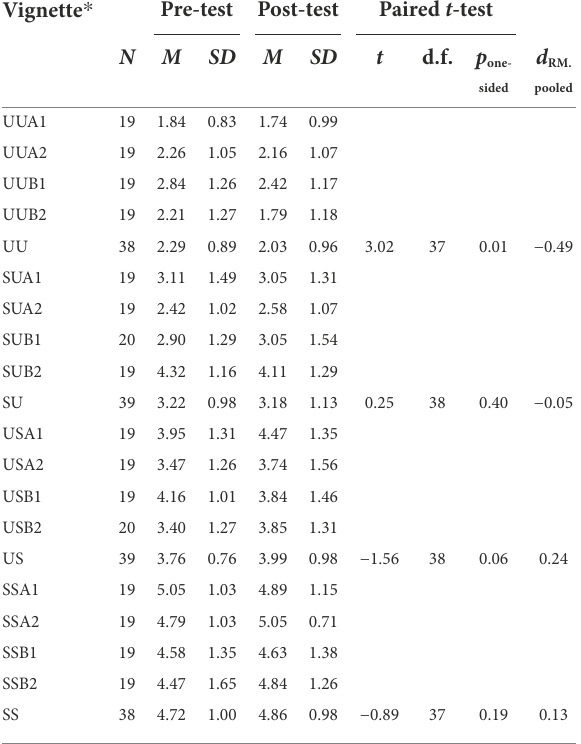
TABLE 3 Vignette ratings in the intervention study and results of comparisons between pre- and post-test